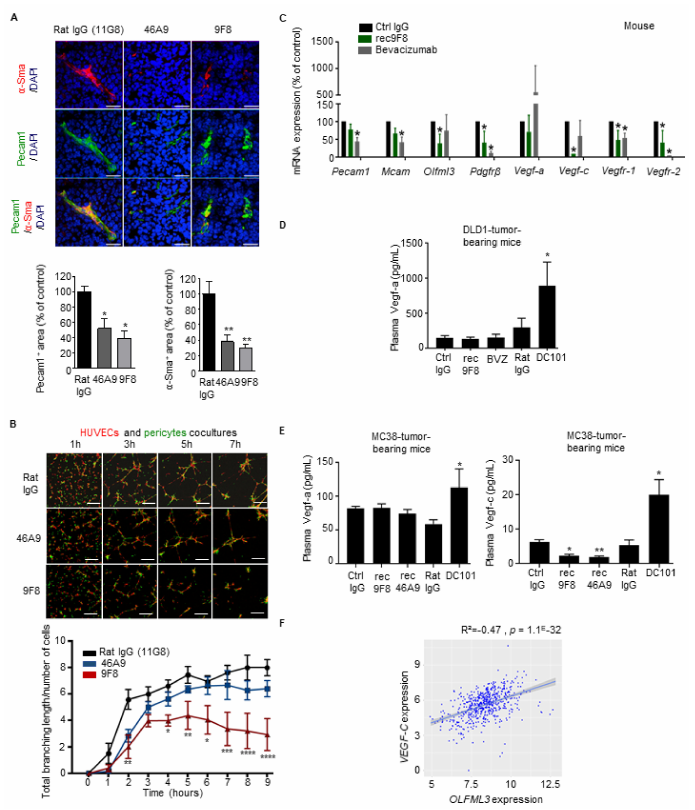
Figure 4. Anti-OLFML3 antibody treatment decreases vascularization, pericyte coverage, and ex- pression of angiogenesis-associated factors in colorectal and lung tumors. ( A ) Vascularization of LLC1 lung tumors. Upper panel: representative confocal images comparing α -Sma+ pericytes (red), Pecam1+ endothelium (green), and Pecam1+/ α -SMA+ double staining (green and red) in LLC1 tumors grown in mice treated with isotype control rat IgG (11G8) or the anti-Olfml3 antibodies 46A9 or 9F8. DAPI (blue), nuclear counterstain. Bars, 100 µ m. Lower panels: quantification of vessel density, expressed as the ratio of the total pixel count for Pecam1 to that for DAPI, normalized against control rat IgG ( left ). Quantification of pericyte density expressed as the ratio of total pixel count for α -Sma to that for DAPI, normalized against control rat IgG ( right ). Ten individual images of tumors, taken in three planes, were analyzed (five mice per group). Error bars represent ± SEM; * p < 0.05; ** p < 0.01. ( B ) Coculture of HUVECs with human brain pericytes. Upper panel: representative confocal images taken at the indicated times after seeding of cocultures of HUVECs (red) and human brain pericytes (green) in 3D Matrigel in the presence of 9F8, 46A9, or rat control mAbs. Lower panel: quantification of total branch length of capillary-like networks. Results represent the mean value ± SEM (three experiments, each group analyzed in triplicate); * p < 0.05; ** p < 0.01; *** p < 0.001; **** p < 0.0001. ( C ) Expression profile of mouse mRNA expression using NanoString arrays of DLD1 CRC tumors. Angiogenic factors in DLD1 tumors from mice treated with rec9F8, bevacizumab, or control IgG mAbs. Results are normalized against the values for control IgG-treated tumors. Columns represent the mean ± SEM (three experiments); * p < 0.05. ( D , E ) ELISA measurement of angiogenesis-associated factors in plasma of tumor-bearing mice. ( D ) Vegf-a in mice bearing DLD1 human CRC tumors treated with rec9F8, bevacizumab, DC101, or the corresponding control IgG antibodies (Ctrl IgG, Rat IgG). ( E ) Quantification of Vegf-a or Vegf-c in mice bearing MC38 mouse CRC tumors treated with rec9F8, rec46A9, DC101, or control IgG antibodies. ( F ) Scatter plots with linear regression lines (blue) showing the correlation among the NanoString mRNA expression profiles of OLFML3 and VEGF-C mRNA levels in tumor samples from CRC patients, calculated using Pearson’s and Spearman’s rank correlation analyses. Differences between groups were determined using an unpaired Student’s t